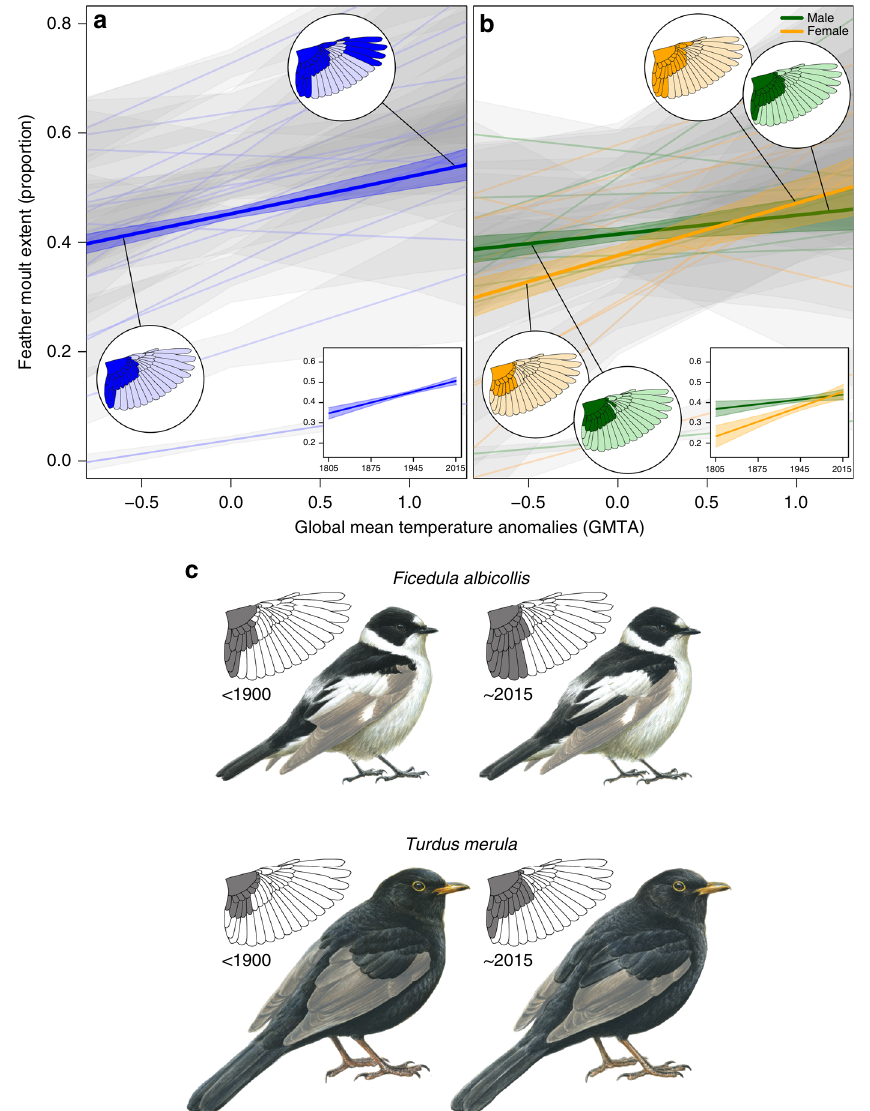
Fig. 1 The relationship between global mean temperature anomalies (GMTA) and feather moult extent. a The extent of post-juvenile moult of 19 passerine species, shown separately for each species (thin lines ± 95% con fi dence intervals, CIs) and the general trend (bold line ± CIs). The trend indicates a signi fi cant increase of moult extent with increasing GMTA in 16 species ( Δ AICc ≥ 2.10; Supplementary Table 3). The two circled insets depict the extent of wing moult in the beginning and the end of the examined period (1805 – 2016). The boxed inset illustrates the general trend of moult extent across the study period (years). b Male and female moult extent of 10 sexually dichromatic passerine species throughout the examined period, shown separately for each species (thin lines ± CIs) and the general trend (bold line ± CIs). In four species, the results indicate a stronger response to warming climates in females than in males ( Δ AICc ≥ 3.80), leading to an overall more extensive moult of females than that of males since ~1990. Thus, in these species, females replaced more feathers than males under warmer conditions. c Two examples demonstrating how the increasing extent of moult changed the appearance of a fi rst year male Collared Flycatcher Ficedula albicollis (top two illustrations) and Eurasian Blackbird Turdus merula (bottom two illustrations) before 1900 (left) compared to 2015 (right). Since the birds moulted more feathers in recent years, their present-day plumage appears more similar to